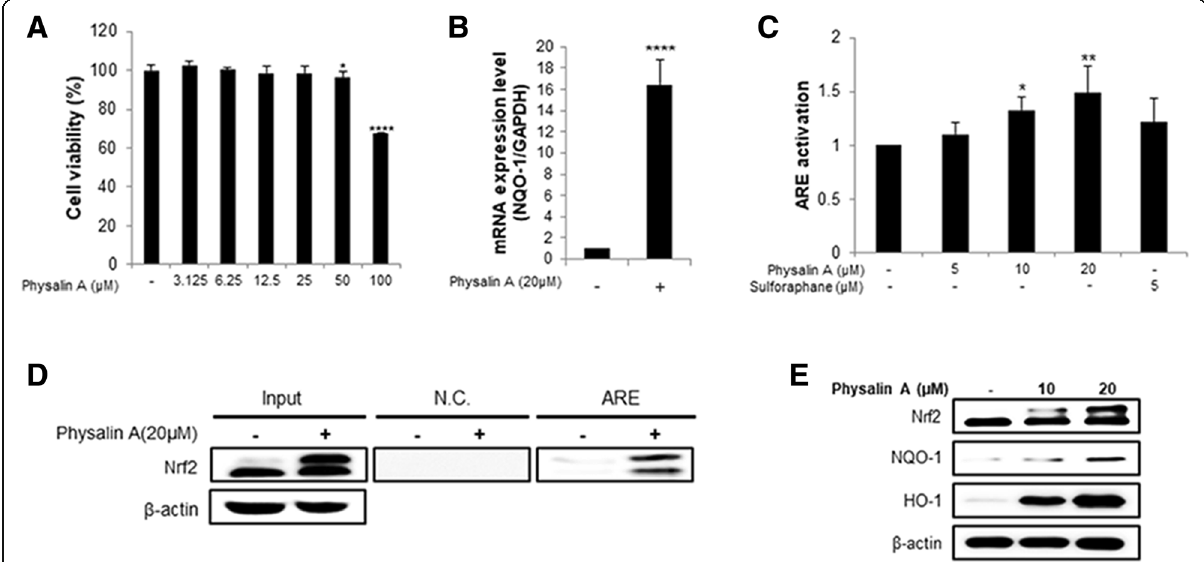
Fig. 4 Physalin A induces NQO-1 transcription in HepG2 cells. a Viability of physalin A-treated HepG2 cell line. Cells treated with various concentration physalin A for 24 h. b NQO-1 expression was measured using real-time PCR. c ARE transcriptional activity of physalin A-treated HepG2 cells. The cells were treated with 5, 10, 20 μ M physalin A for 24 h and cell lysates were used for luciferase assay. d Oligonucleotide pull- down assay in HepG2 cells with ARE element. The cells were treated 20 μ M physalin A for 4 h and then harvested to determine ARE-binding activity. e Western blot analysis to assess the expression of Nrf2 and its target genes, NQO-1 and HO-1 in HepG2 cells. The cells were treated with 10 and 20 μ M physalin A (*: p < 0.05, **: p < 0.01, ***: p < 0.001, ****: p < 0.0001)